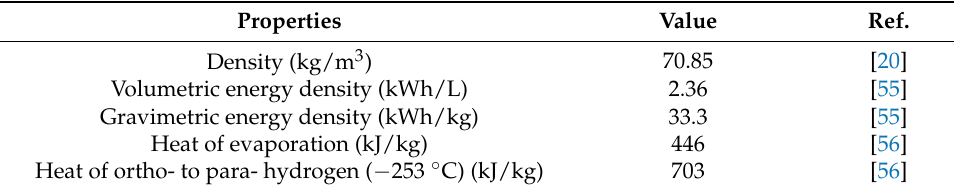
Table 3. Physical properties of liquid hydrogen.